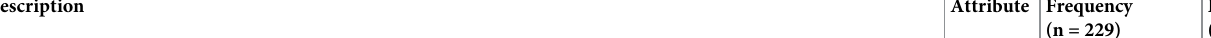
Percentage (n = 229)